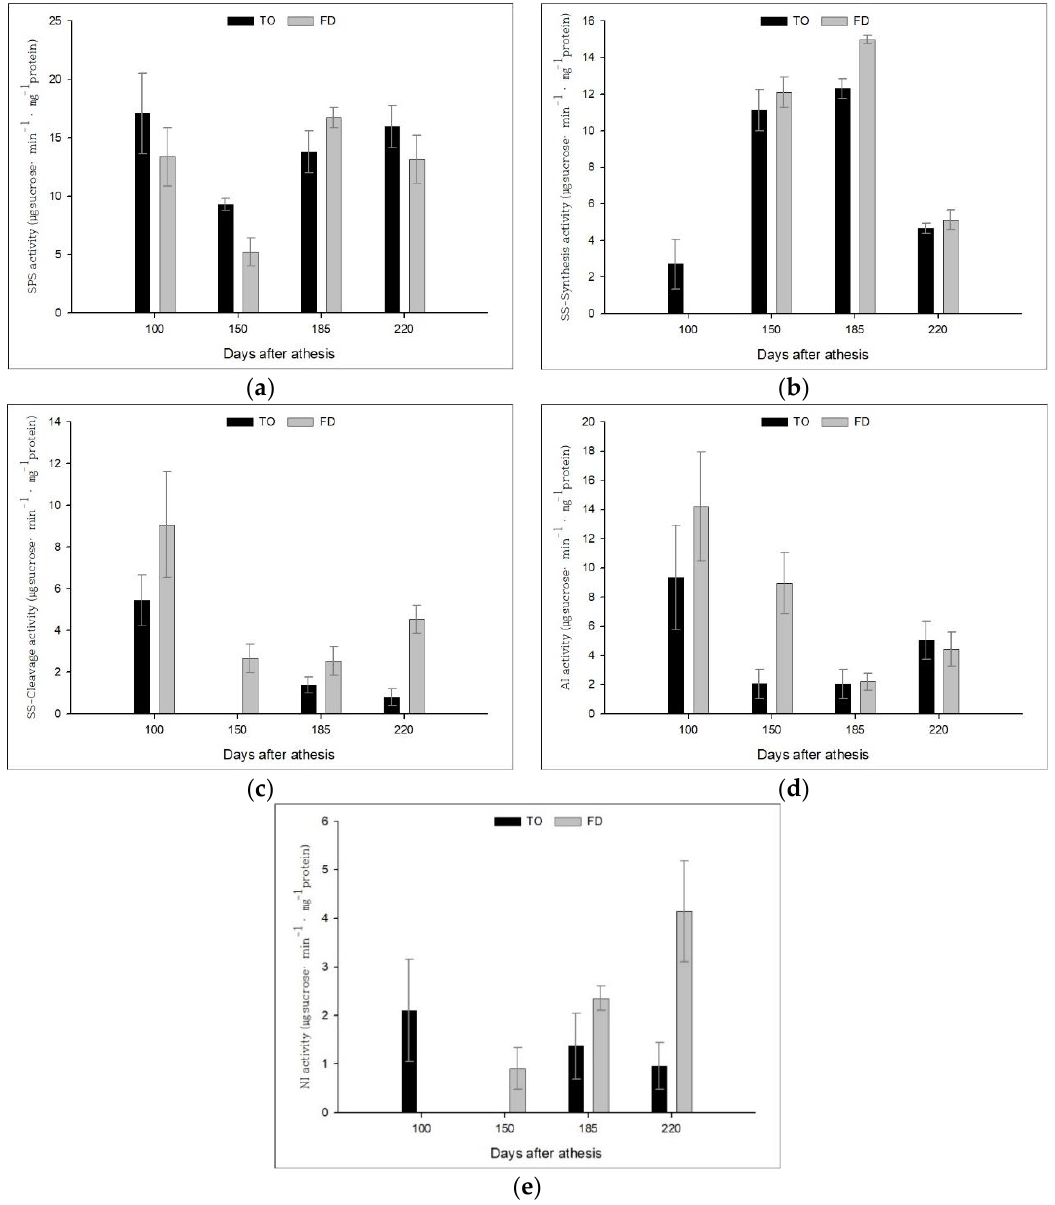
Figure 4. Sucrose metabolic enzyme activities in the fruit of ‘Minihyang’ mandarin grafted on different rootstocks. ( a ) SPS activity; ( b ) SS-synthetic activity; ( c ) SS-cleavage activity; ( d ) AI activity; ( e ) NI activity.